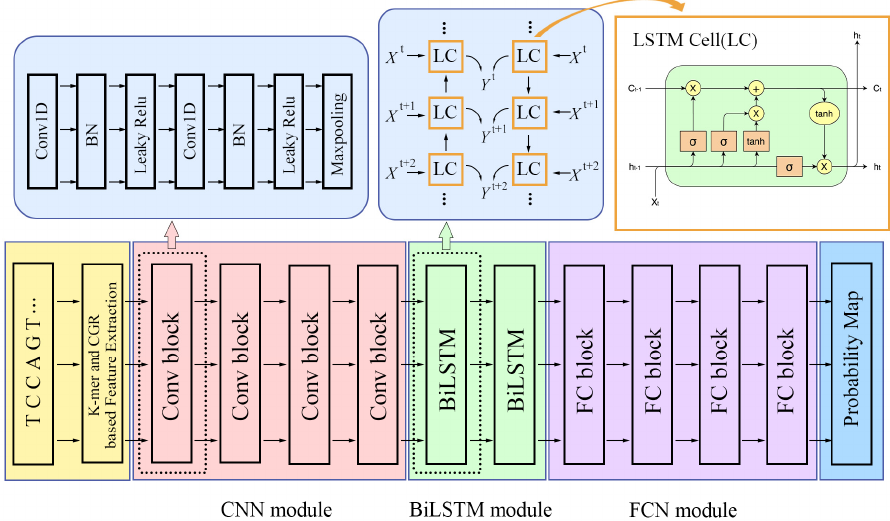
Figure 4. An illustration of DeepmRNALoc architecture. The CNN module contains four CNN blocks, with each CNN block consisting of two CNN layers. The BiLSTM module consists of two BiLSTM layers. The FCN module consists of four fully connected neural network layers.